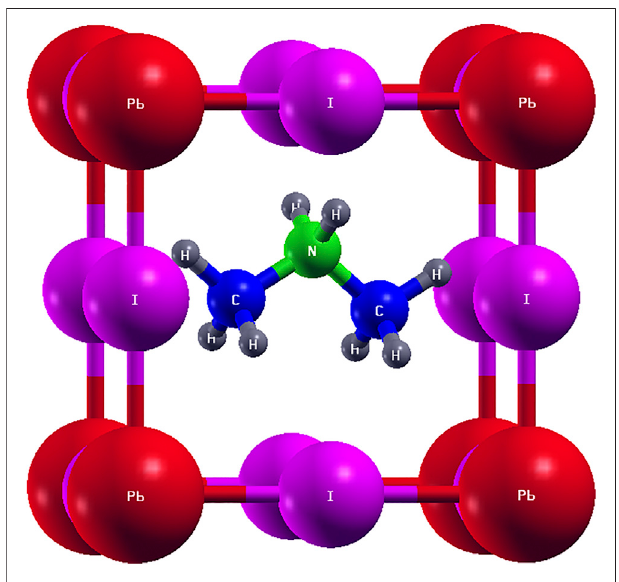
FIGURE 1 | Cubic crystal structure of (CH 3 )NH 2 CH 3 PbI 3